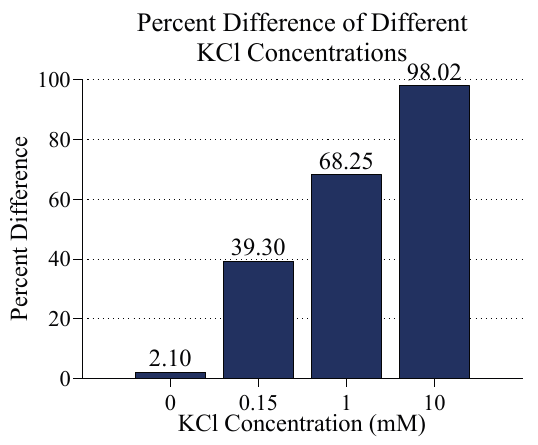
Figure 7. The percent difference in the electric field magnitude at the center of the gap between electrodes digits with and without 60 nm GNPs at different KCl ion concentrations. GNPs are 20 nm above electrodes, electrodes have 5 µm digits with 2.5 µm gap space and 0.1 V applied voltage.